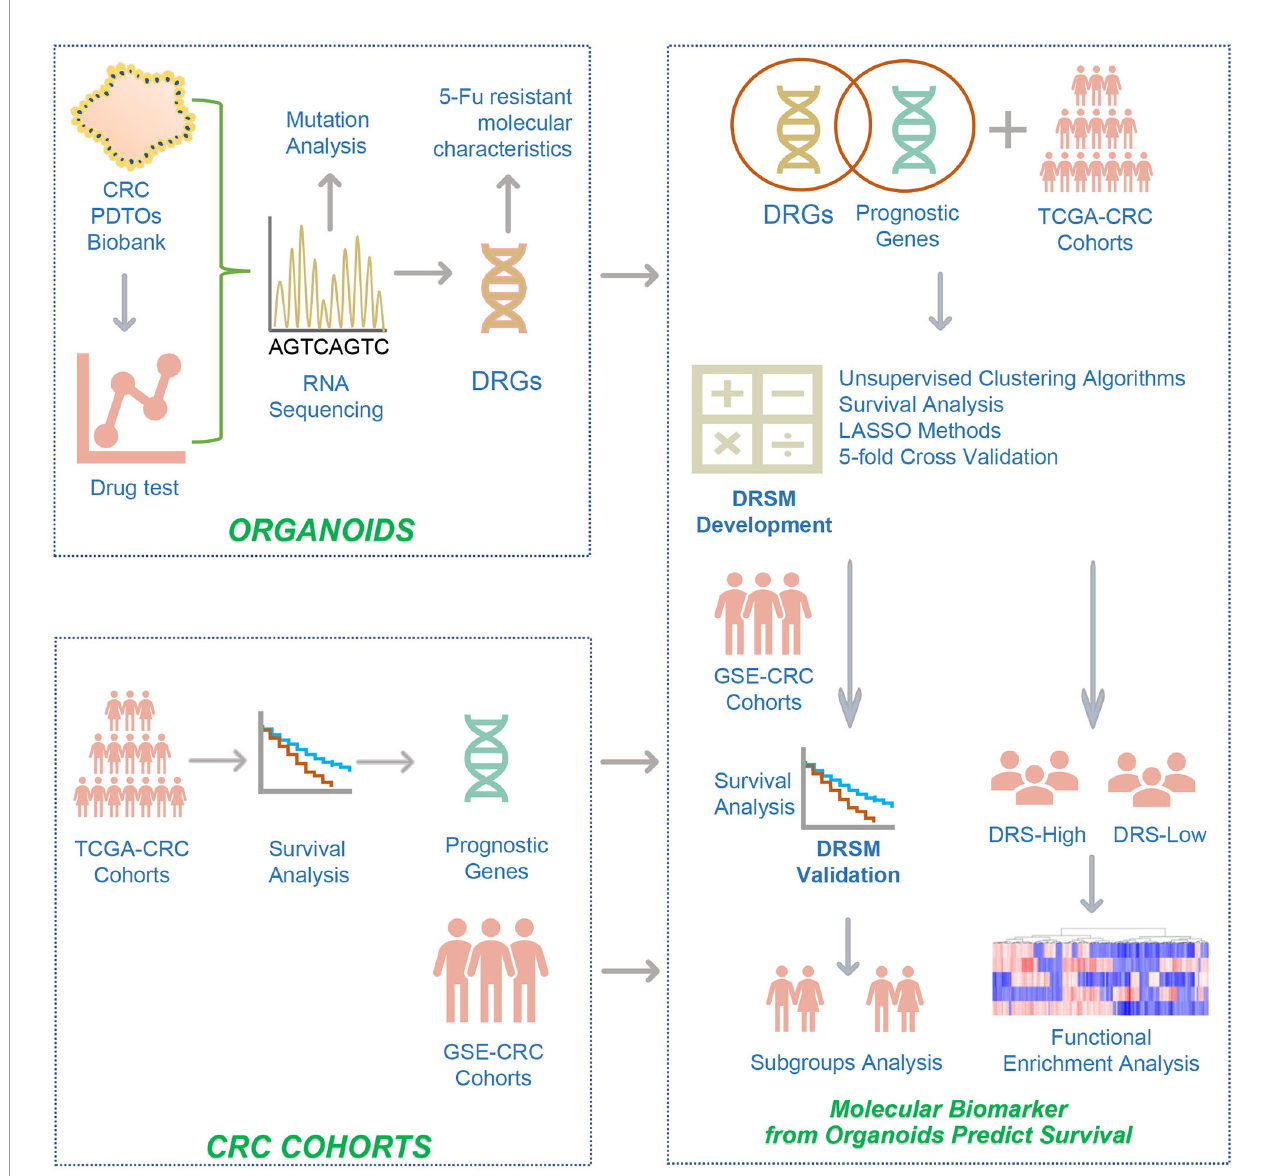
FIGURE 1 | The overall fl owchart depicting the development and validation of the gene signatures and drug-resistant score model. The study design was described in detail in the Methods (Study design). CRC, colorectal cancer; PDTOs, patient-derived tumor organoids; 5-Fu, 5- fl uorouracil; DRGs, drug-resistant genes; TCGA, the cancer genome atlas; GSE, gene expression omnibus series; LASSO, least absolute shrinkage and selection operator; DRSM, drug-resistant score model; DRS, drug resistant